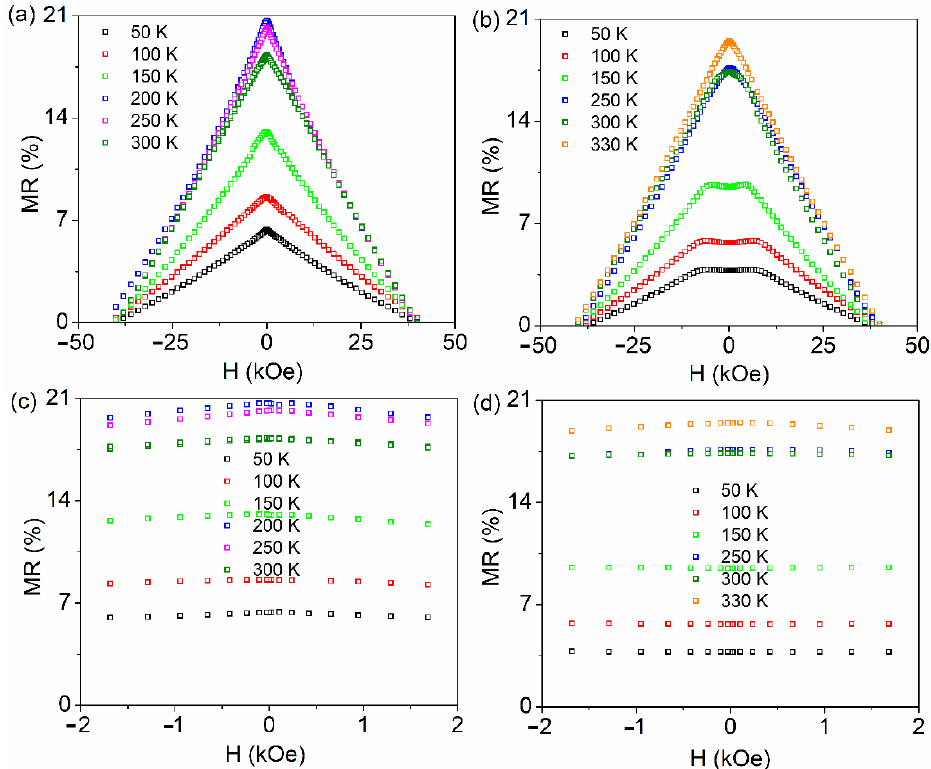
Figure 9. MR curves of LSMO 60 sample collected in parallel ( a ) and perpendicular ( b ) geometry. MR curves collected in parallel ( c ) and perpendicular ( d ) geometry in the low field region.